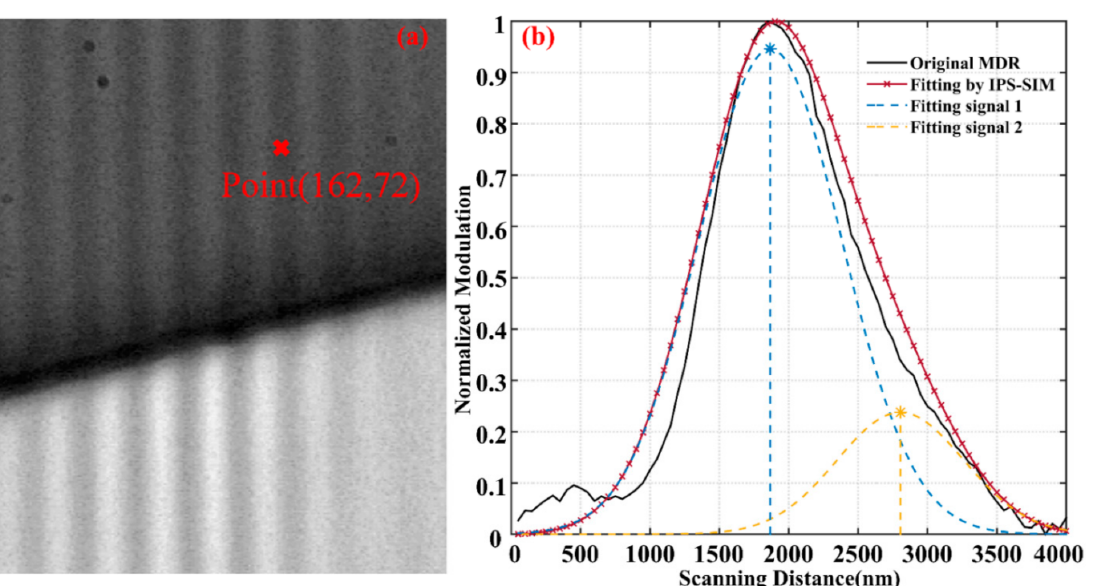
Figure 8. ( a ) The image of the patterned sample captured by CCD at the scanning position of 1700 nm. ( b ) The normalized MDR curve (black) at the pixel (162,72) and the IPS-SIM fitting